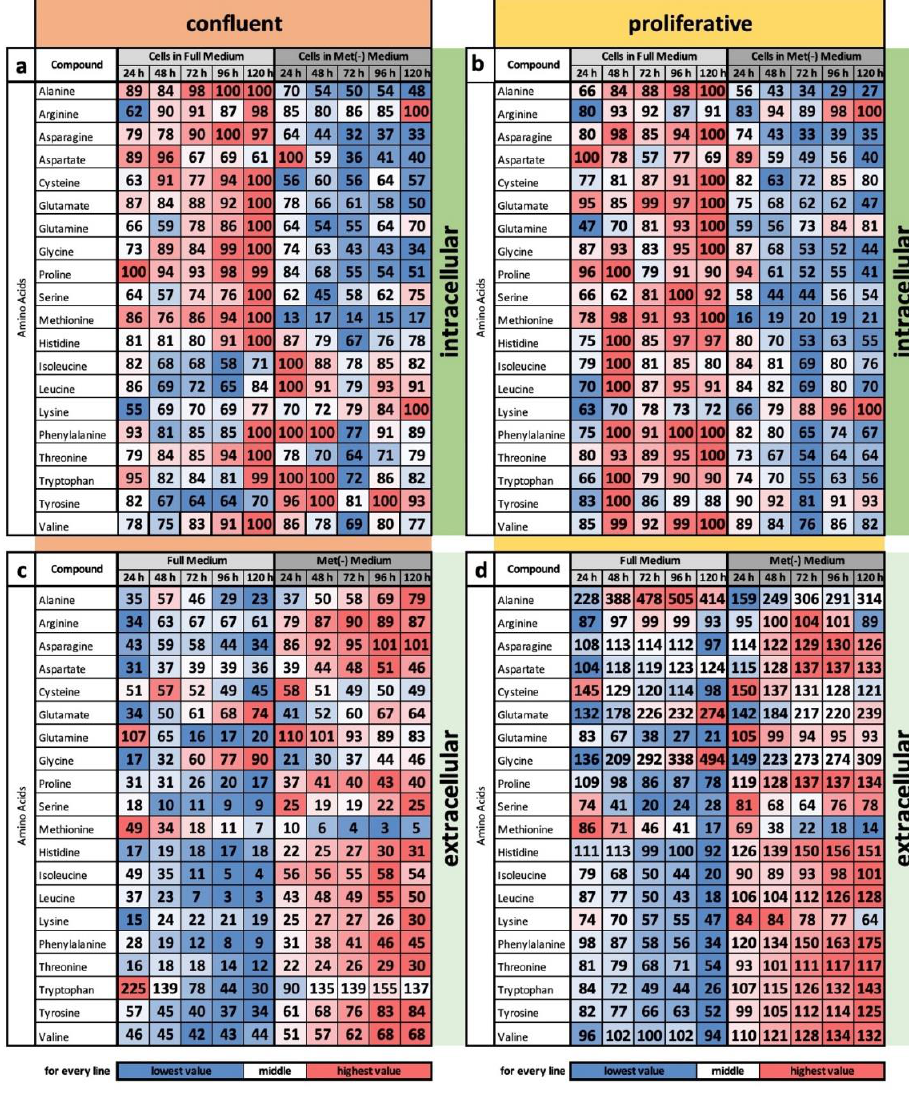
Figure 2. ( a – d ) Relative amounts of proteinogenic amino acids under MetR comparing confluent and proliferative conditions with the cell line L929. The metabolism of the murine cell line L929 was analysed in full medium and MetR under both confluent ( a , c ) and proliferative conditions ( b , d ) over a period of 5 days. For each day of the experiment, the preparation was performed in triplicate. After 24, 48, 72, 96 and 120 h, both the medium (extracellular) and the cell lysates (intracellular) were analysed by LC/MS. The results were reproduced in four independent experiments and finally summarized. In this figure, the results of the proteinogenic amino acids are shown. For the values of the media, the control measurement of the medium used was defined as 100%. For the cell pellets, the highest measured value in each test series was defined as